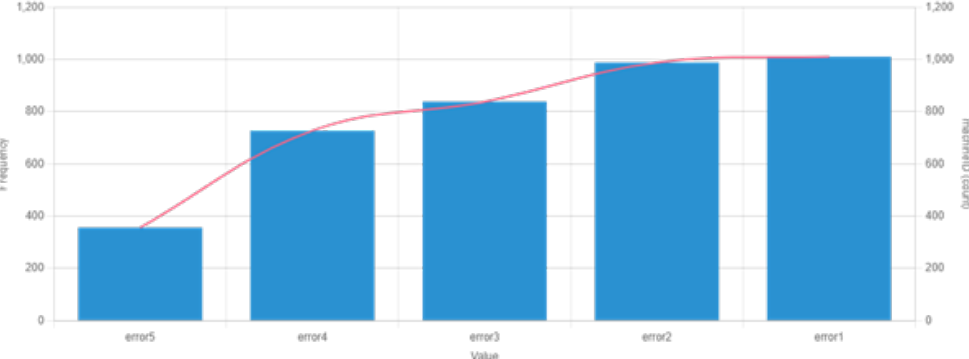
Figure 7. Frequency of different error conditions along with a set of 100 machines. Table 1. A detailed description of different data sources.